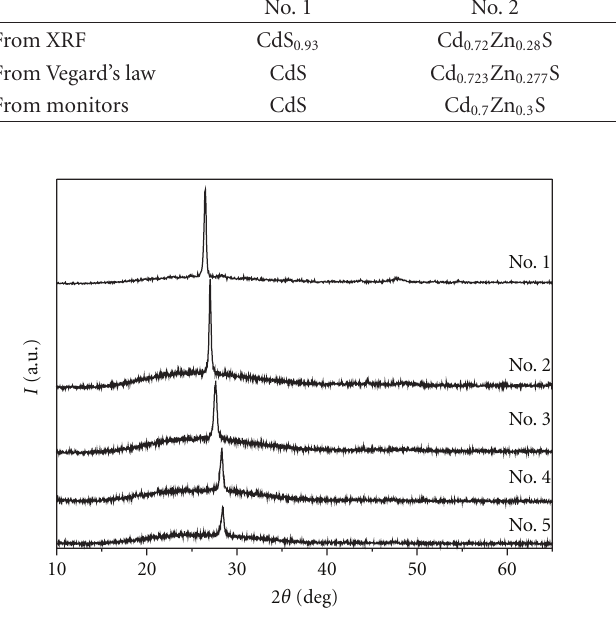
Figure 3: UV-visible transmission spectra of Cd 1 − x Zn x S